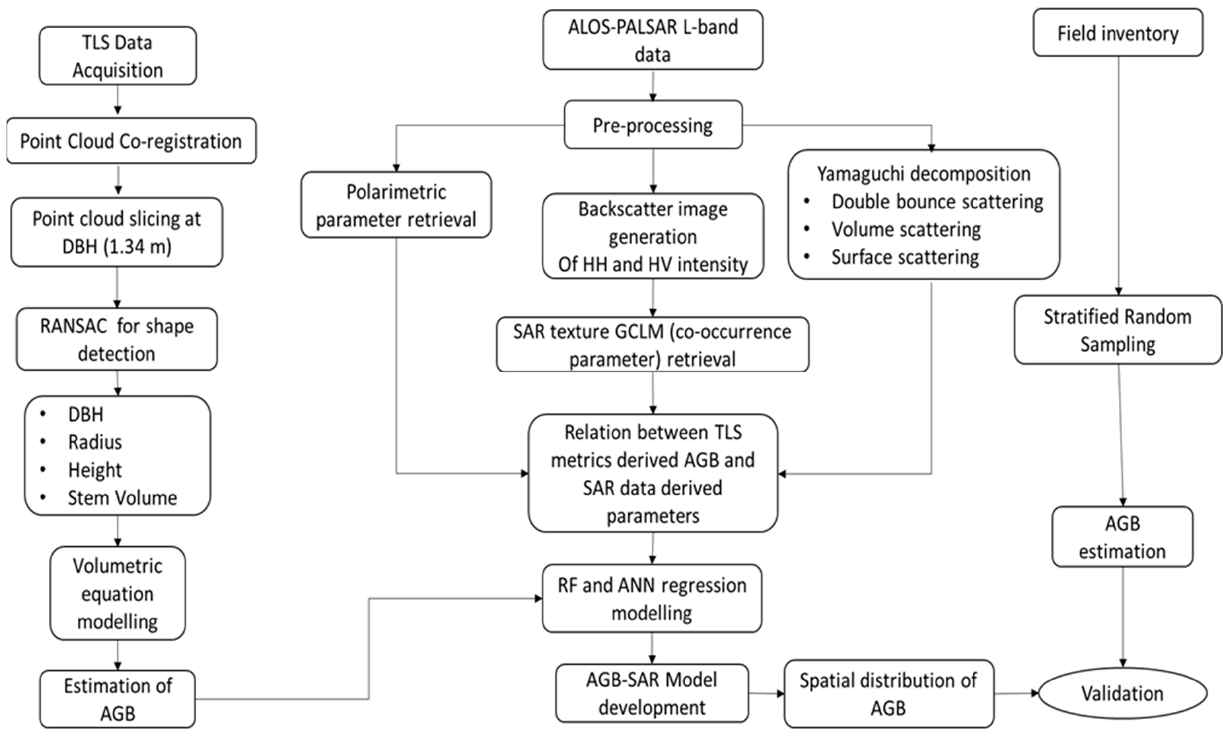
Figure 5. Methodology flowchart.